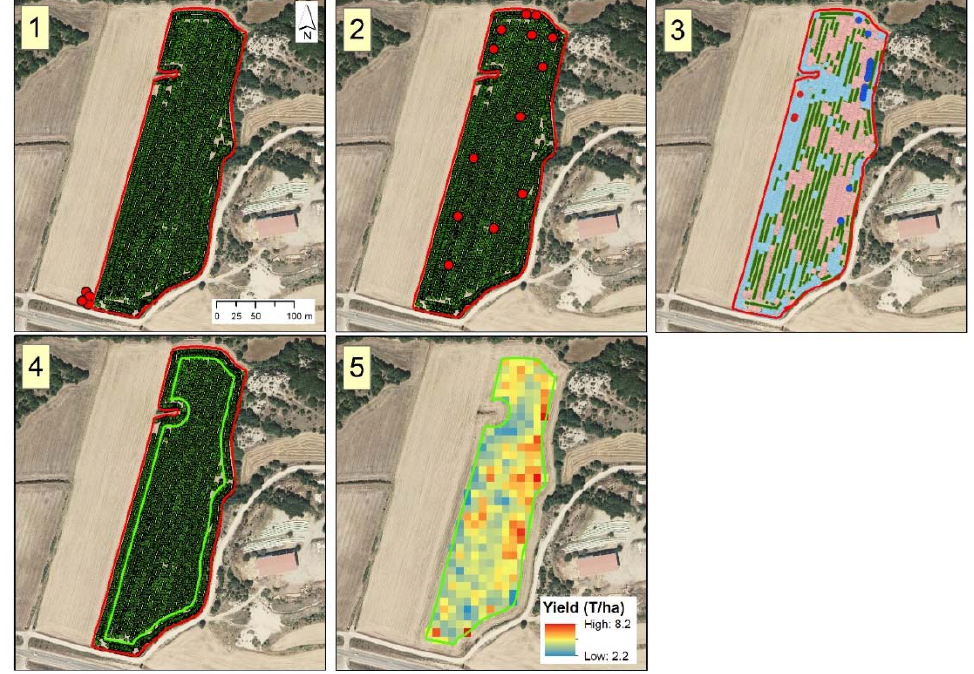
Figure 3. Preprocessing of yield monitor data followed in all plots. Example: Ollavarre plot: ( 1 ) re- move points out of the plot, ( 2 ) remove points out of the stablished threshold, ( 3 ) remove outliers and Anselin-Moran local outliers (red/blue), ( 4 ) remove points out of the green buffer, ( 5 ) interpolate yield values.